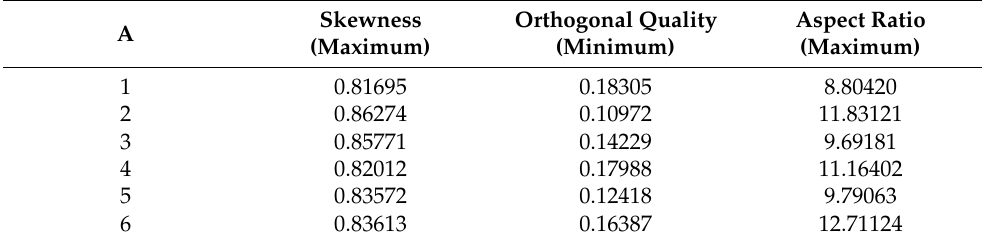
Figure 6. ( a ) Tetrahedral mesh for fluid domain and boundary conditions. ( b ) Triangles mesh for solid domain and boundary conditions. Corresponds to A-6 model. Table 4. Final mesh quality parameters for each aneurysm